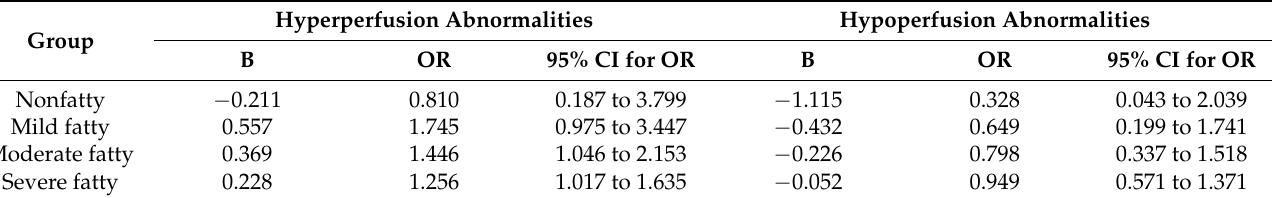
Table 2. Correlation between liver fat content and hepatic perfusion disorders in the nonfatty liver group and each subgroup of the fatty liver group.